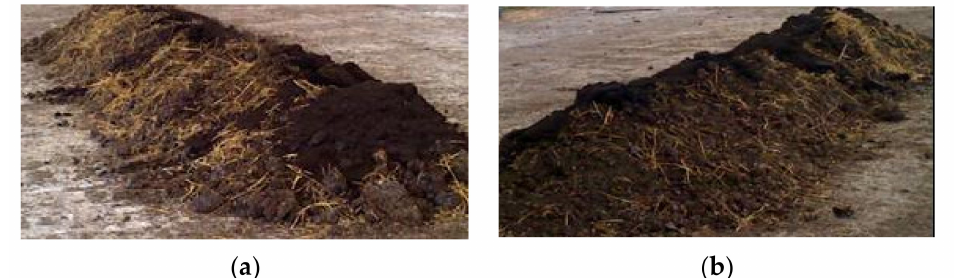
Figure 3. Pile A ( a ) and B ( b ) at day 0.